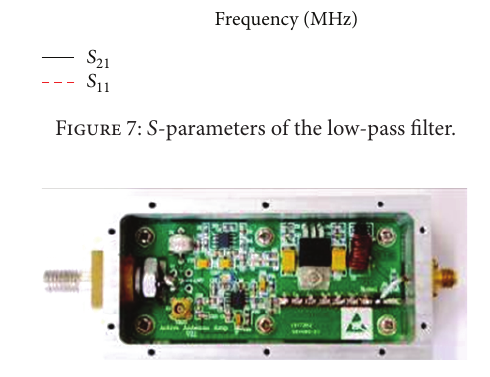
Figure 8: Photograph of the active network.